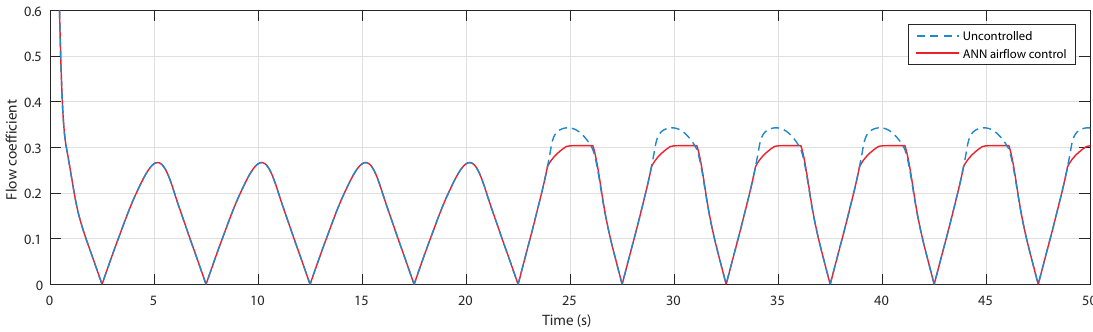
Figure 16. Flow coefficients for uncontrolled case and ANN-based airflow control.